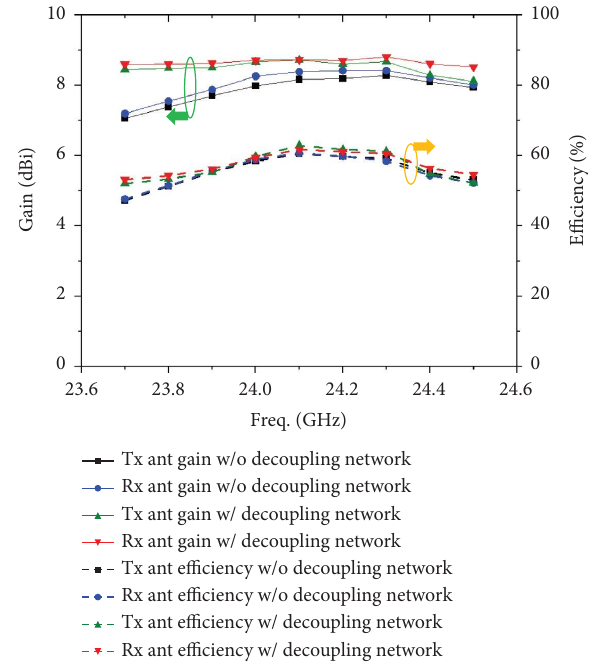
Figure 19: Measured gains and efciencies of Tx/Rx antennas without and with the decoupling network.